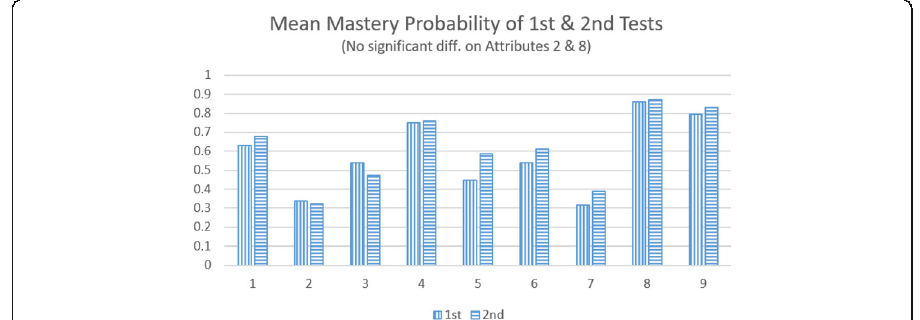
Fig. 2 Mean mastery probability of the first and second tests. Note. 1. simple present/ progressive; 2. zero conditional; 3. simple past/progressive; 4. participles; 5. subject-verb agreement; 6. relative pronoun; 7. used to; 8. vocabulary; 9. expressions